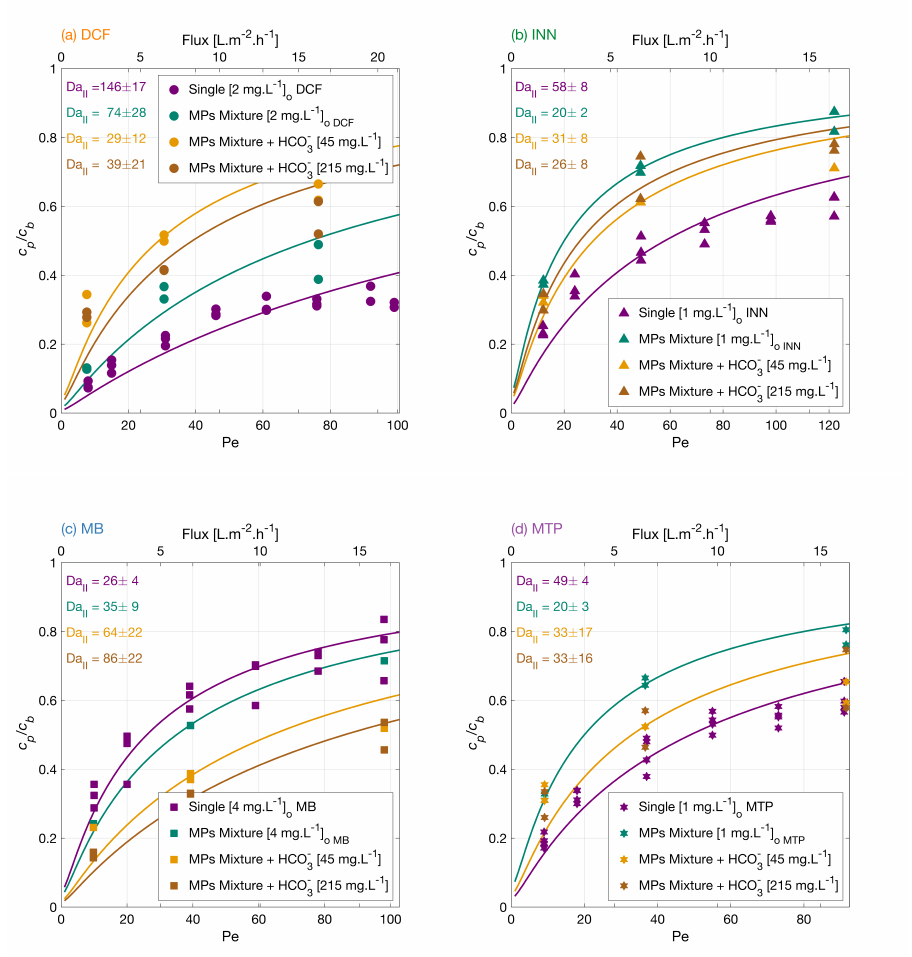
Figure 4. Degradation of ( a ) DCF, ( b ) INN, ( c ) MB, and ( d ) MTP, independently, in a mixture, and in a mixture with two concentrations of bicarbonate ions. Symbols depict experimental results, and lines correspond to the mass transport and surface reaction model. Conditions: the legend shows the feed concentrations [ c b ] o , 366 nm radiation, 210 W · m − 2 , and 142 mg · L − 1 Na 2 SO 4